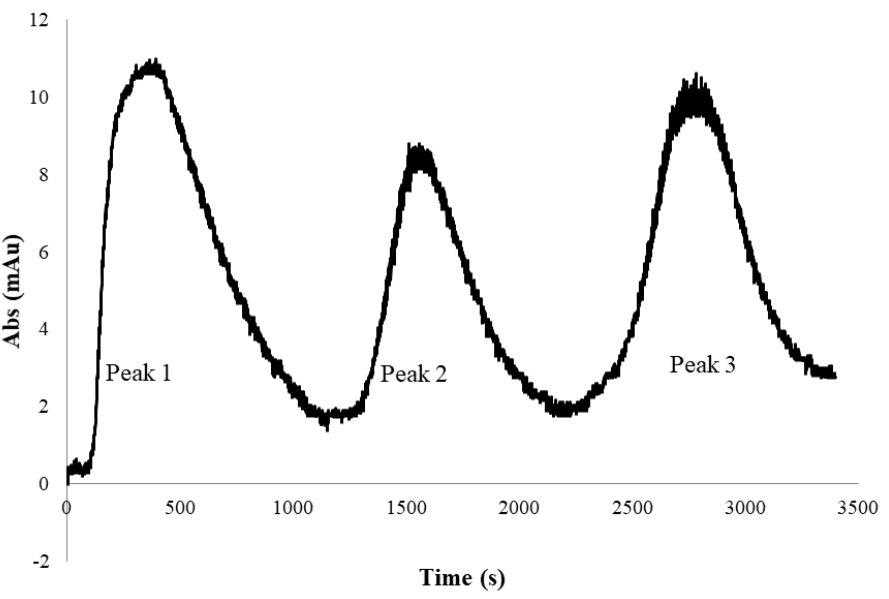
Figure 8. UV absorbance profile of the permeate stream obtained during tangential flow hybrid separation of PEGylated HSA (peak 1: 1.65 M flow-through, peak 2: 1.5 M eluate, peak 3: 0 M eluate).